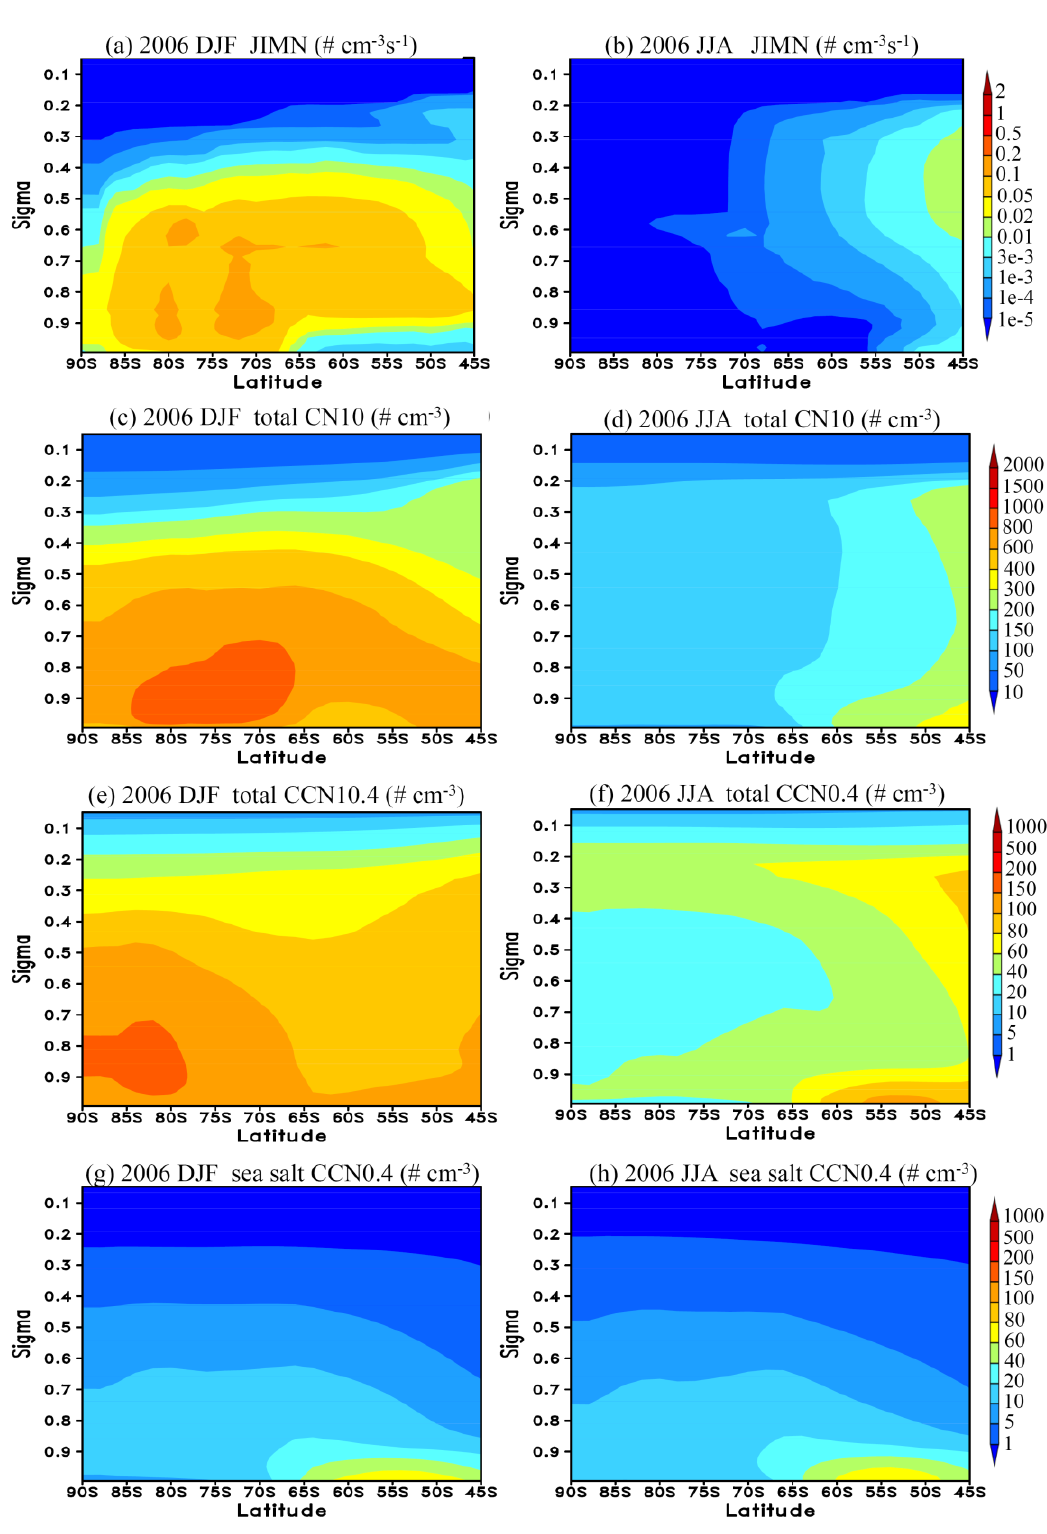
Figure 4. Seasonal means of zonally averaged vertical (sigma = pressure/surface pressure) structures of JIMN, total CN10, CCN0.4 total and CCN0.4 associated with sea salt particles over the Antarctica and the Southern Ocean regions (45° S and south) for DJF and